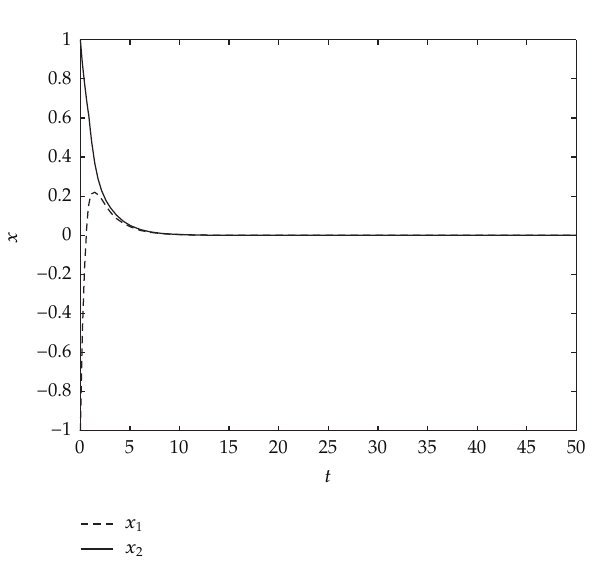
Figure 7: The trajectory of solution of system i (cid:8) 1 under the feedback controller (cid:6) 4.12 (cid:7) .